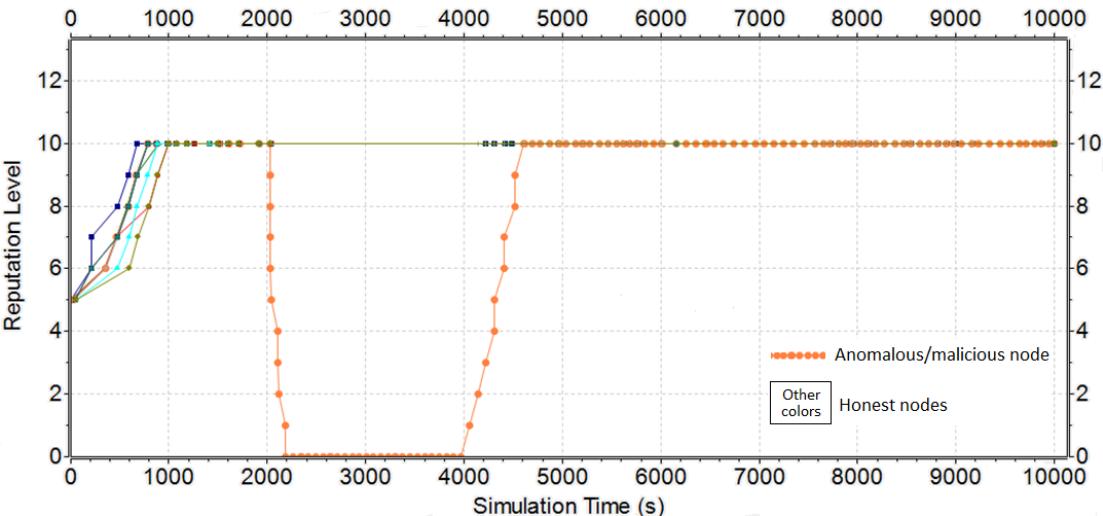
Figure 7. Reputation evolution for betrayal attack—Restricted Scenario.